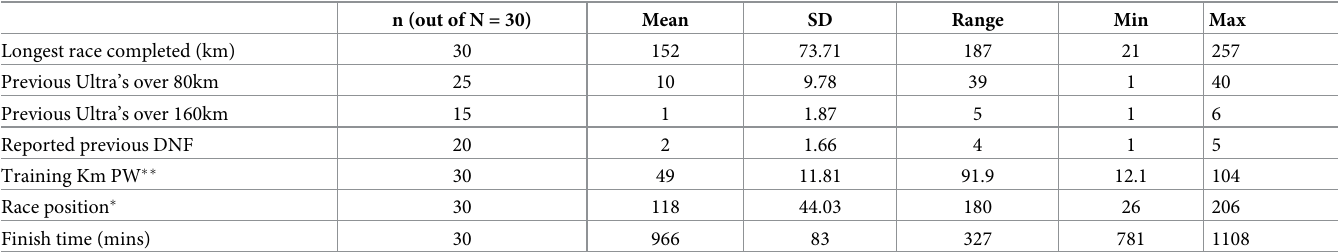
Table 1. Demographic information about race